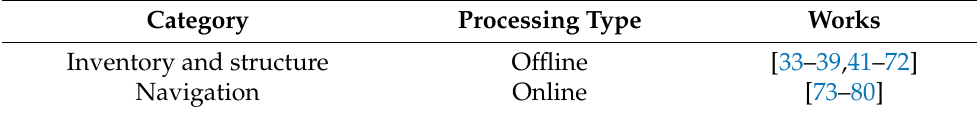
Table 2. Summary of the collect works about LiDAR-based